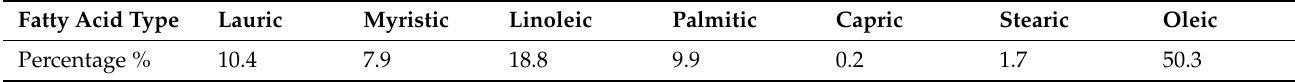
Table 11. Chemical characteristics of DSO.